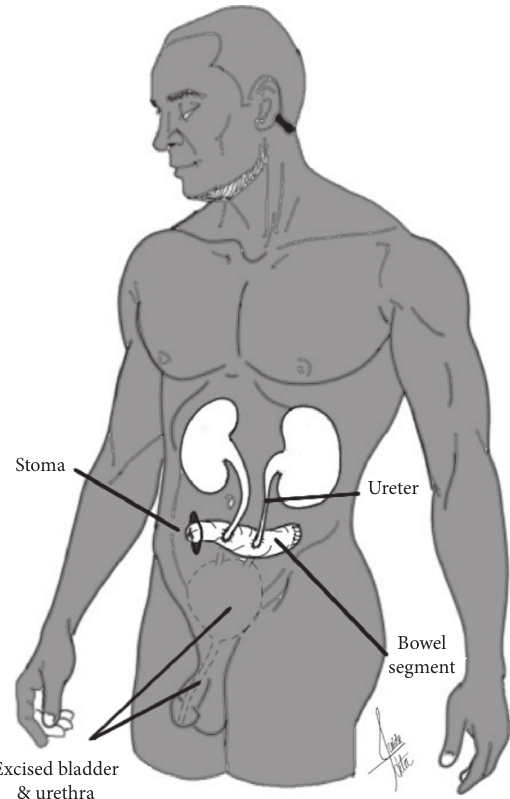
Figure 1: Continent cutaneous diversion. The ureters are attached to a pouch created by a bowel segment (ileum or colon). The pouch is then brought to the skin as a stoma. The urinary bladder and urethra are rendered nonfunctional by surgical removal or